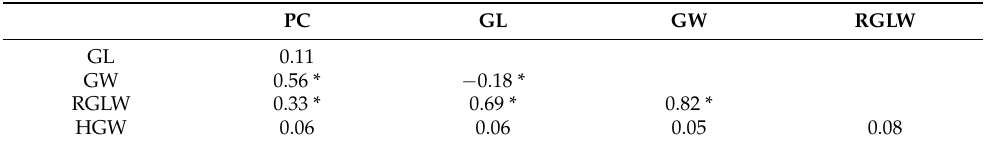
Figure 1. Frequency distribution of number of lines with percent chalk ( A ), grain length ( B ), grain width ( C ), grain length to width ratio ( D ), and hundred grain weight ( E ) of the K/Z (KB x ZHE733) RIL rice population. Abbreviations: Kaybonnet KB/KBNT, lpa ; Zhe, ZHE733. Table 2. Phenotypic correlations between the traits of percent chalk, grain length, grain width, grain length to width ratio, and hundred grain weight of K/Z RIL